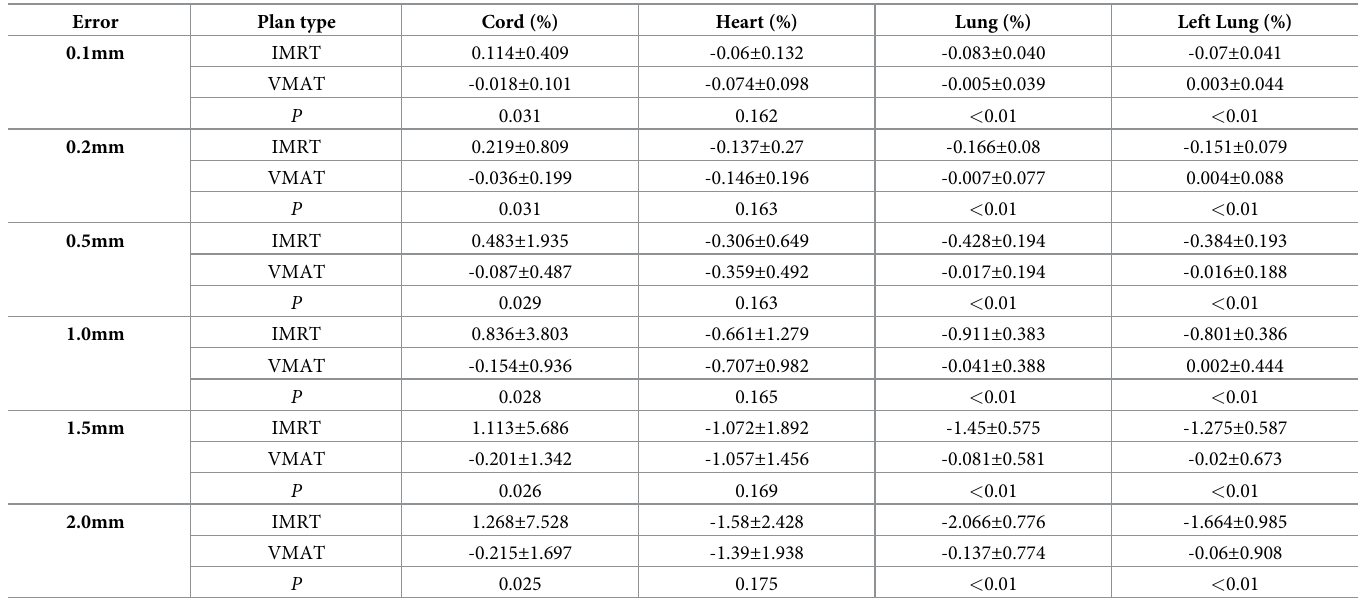
Table 1. The gEUD variation in the OAR of the IMRT and VMAT plan for shift error. Error